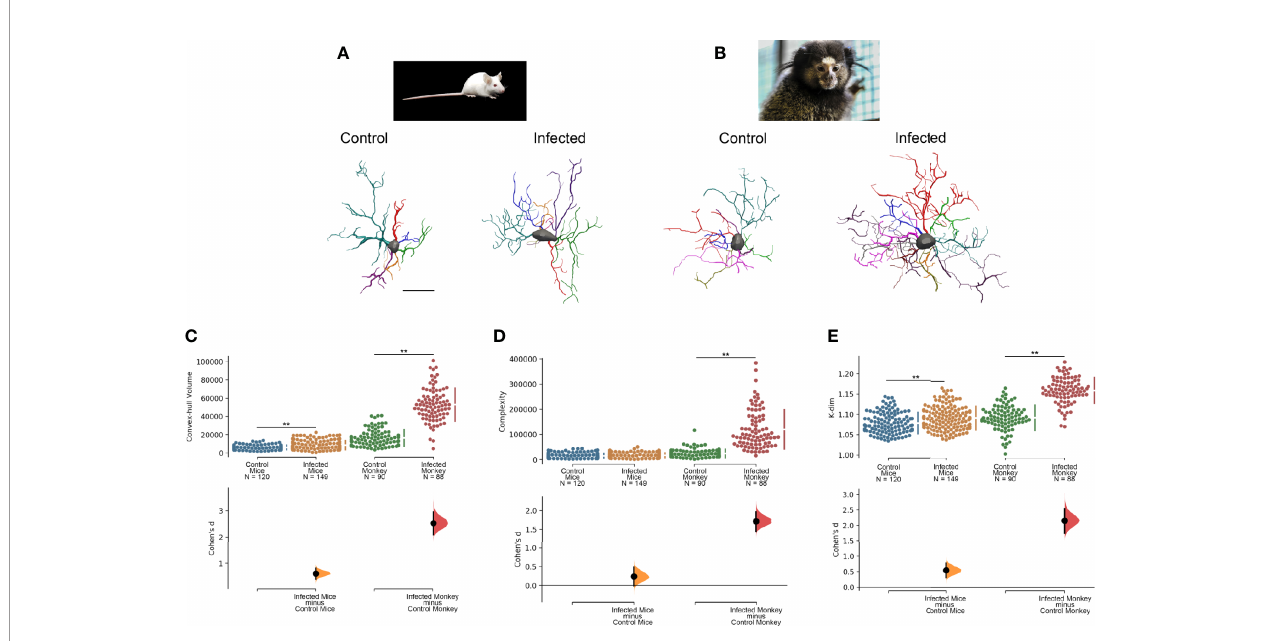
FIGURE 5 | Microglia morphological responses to dengue infection in (A) mouse ( M. musculus ) and (B) black tufted marmoset ( C. penicillata ). (C) Convex hull volume, (D) Complexity and (E) K-dim with Cohen ’ s effect size that was calculated as the mean difference divided by the standard deviation of differences. 3D microglia reconstructions re fl ect the cell closer to the “ mean cell ” of each species. The representative (mean) distance matrix for each cell group was used in the calculation of the sum of each cell distances to all the others. We assumed the cell best representing each group by the least sum of distances. The matrices were constructed using all morphometric variables with the combination of all cells from a given group, followed by the weighted distance measure of a scalar Euclidean distance between the cells. Infected and Control designations over three-dimensional reconstructed cells indicate that microglia were reconstructed from dentate gyrus molecular layer of infected and control individuals, respectively. N indicates de total number of reconstructed microglia. Double asterisk (**) over connector bars denotes statistically signi fi cant difference p < 0.01. Scale bar = 15